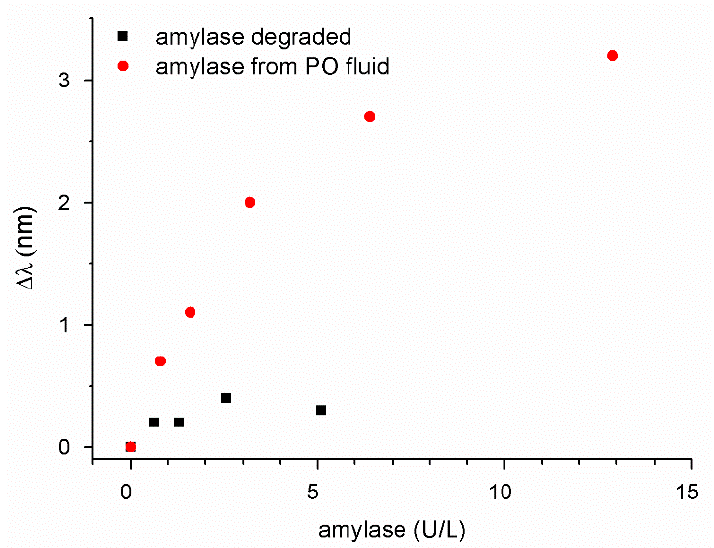
Figure 9. Plasmon resonance wavelength shifts ( ∆ λ ), with respect to the blank, versus the concentration of amylase (U/L). Red circles represent surgically-placed drain effluent; black squares represent amylase degraded (unfolded). Standard deviation associated with the measurements was 0.2 nm. Table 4. Comparison between the determination of the amylase (U/L) made by the POF-biosensor and the enzymatic colorimetric test used as the gold